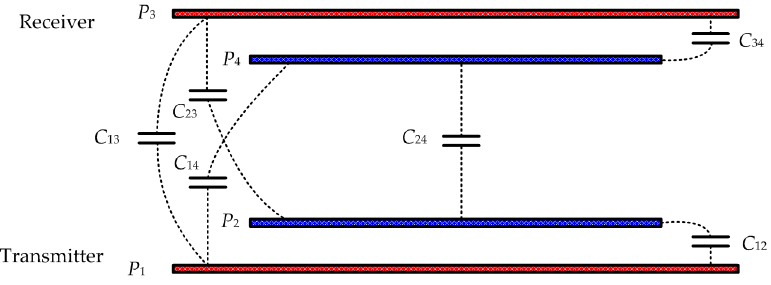
Figure 24. Structure of a four-plate stacked capacitive coupler.